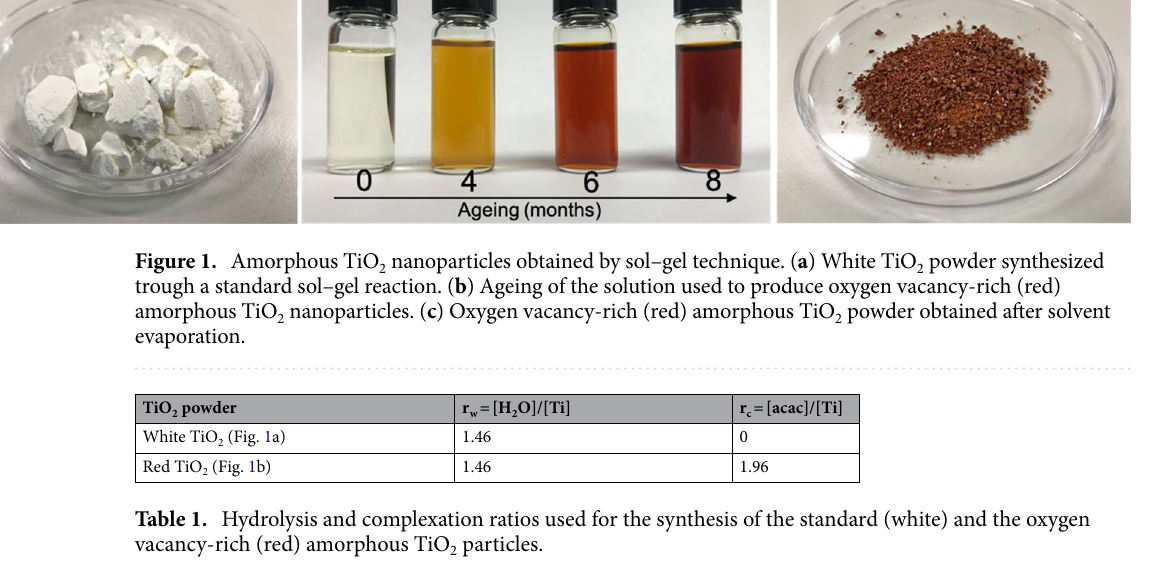
Ti (cid:31) OBu n (cid:30)